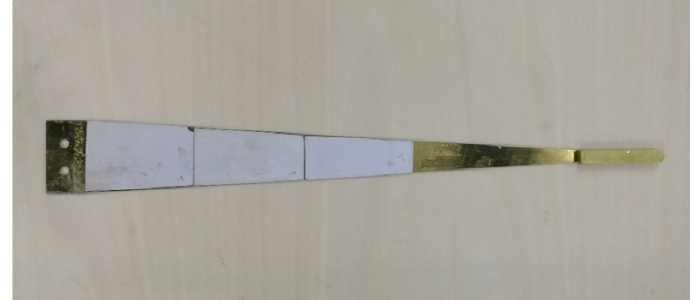
Figure 19. The photo of triangular PCB.